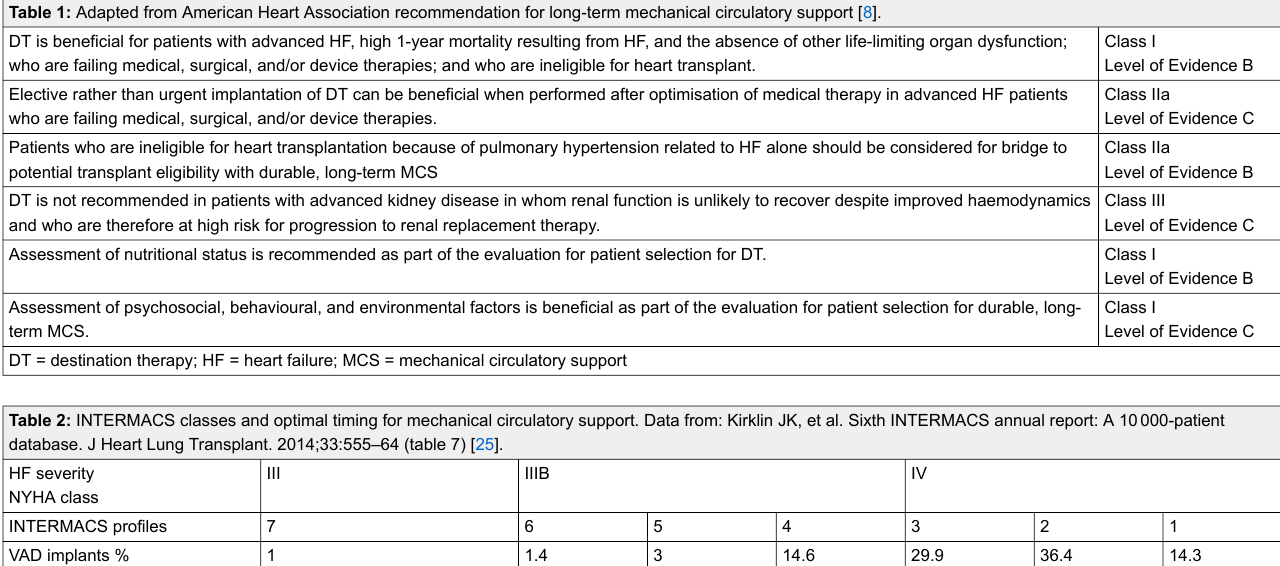
Table 1: Adapted from American Heart Association recommendation for long-term mechanical circulatory support [8]. DT is beneficial for patients with advanced HF, high 1-year mortality resulting from HF, and the absence of other life-limiting organ dysfunction; who are failing medical, surgical, and/or device therapies; and who are ineligible for heart transplant.